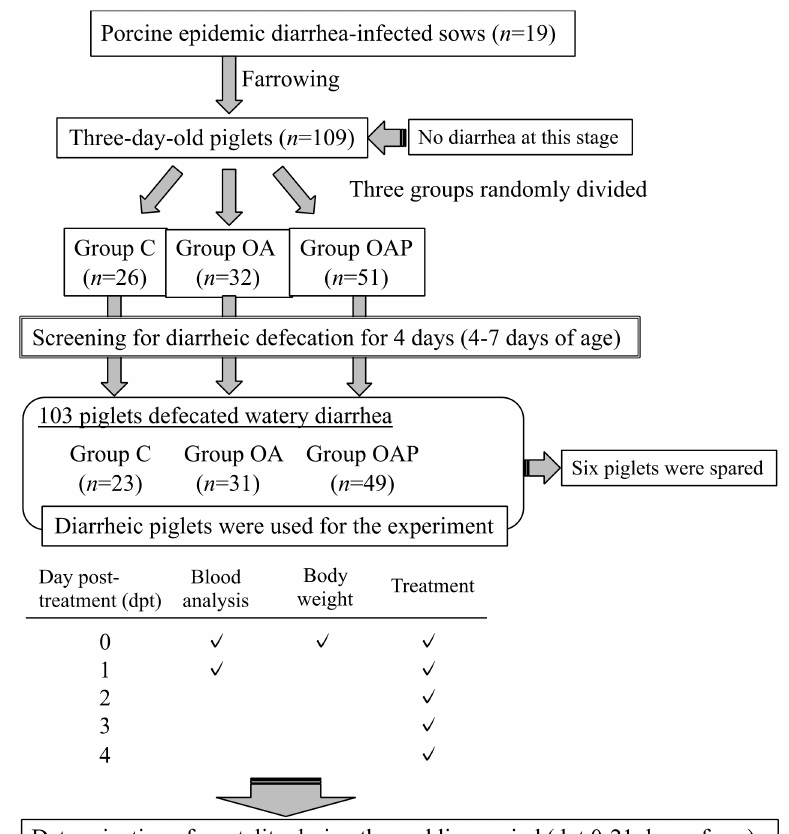
Figure 1. Schematic representation of the experimental design of the study. Group C, untreated control; group OA, piglets receiving oral and abdominal rehydration therapy; group OAP, piglets receiving oral and abdominal rehydration therapy. dpt, days